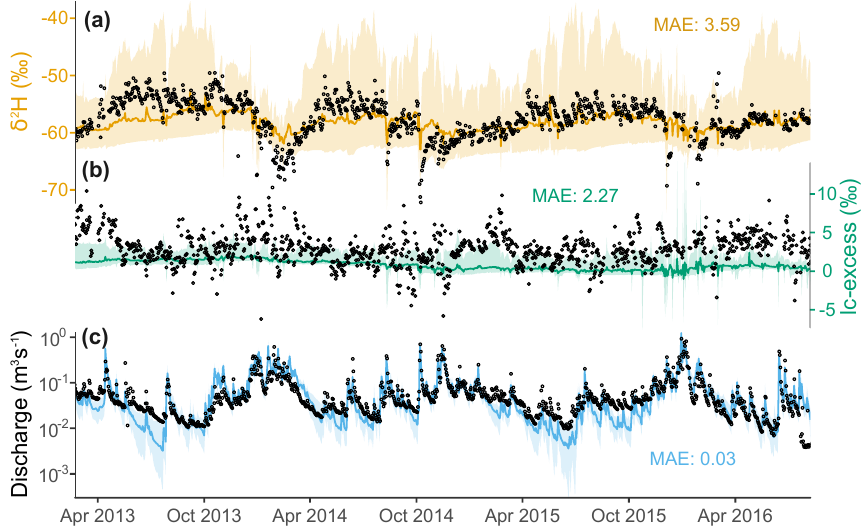
Figure 7. Time series of stream isotopic composition – (a) δ 2 H and (b) lc-excess – and (c) discharge at the catchment outlet. Measurements are shown with black open symbols while colours display the medians and 90% confidence intervals of ensemble simulations, and the model–data MAE values are